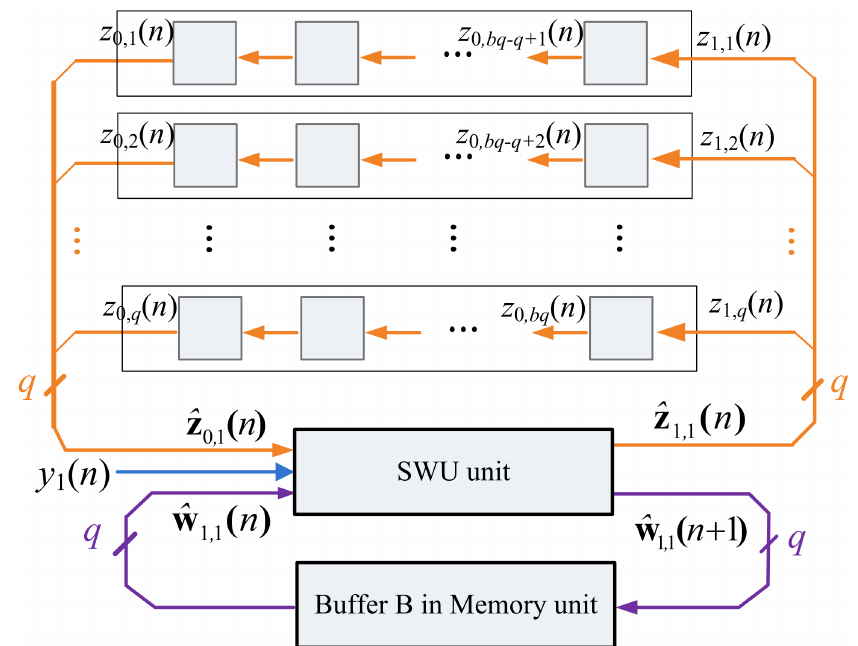
Figure 10. The Buffer B operation for the SWU